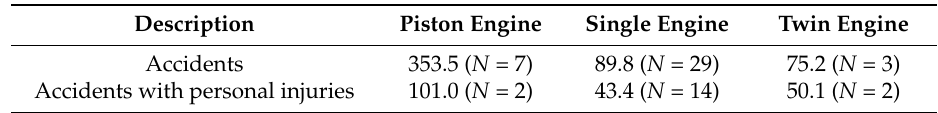
Table 5. Frequency of accidents ( N = 39) and accidents with personal injuries ( N = 18) per million flight hour by motor type among aerial work/PAX operators,